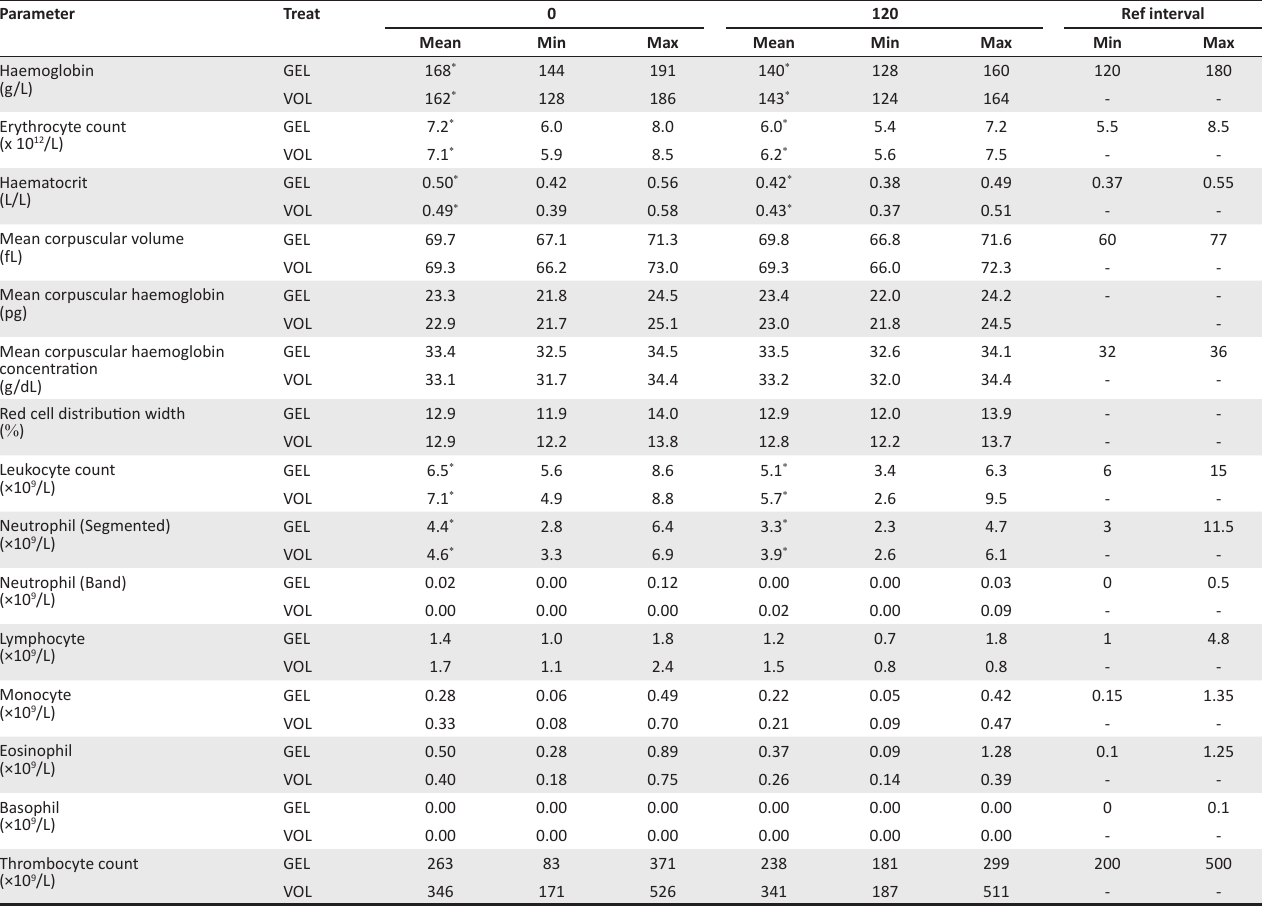
TABLE 3: Haematological variables of eight healthy beagle dogs undergoing colloid fluid infusion for 120 min with 10 mL/kg/h of Gelofusine ® (succinylated gelatin) or Voluven ® (tetrastarch 130/0.4). Variables are reported as mean and range from immediately prior to initiation of infusion (time 0 min) and at the end of infusion (time 120 min). Parameter Treat 0